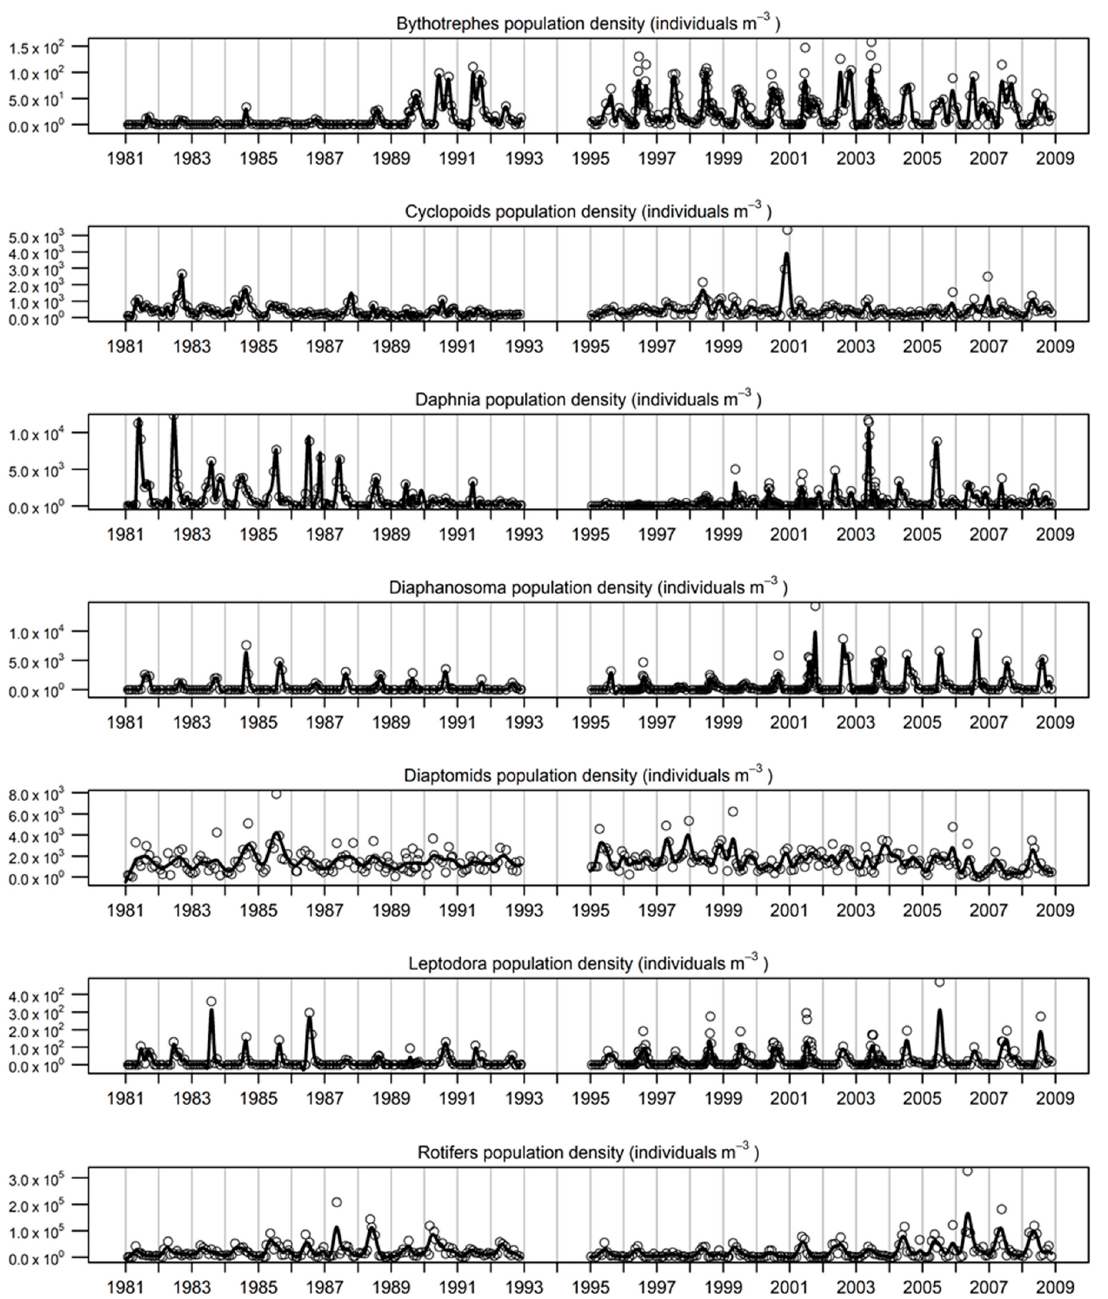
Figure 1. Observed and smoothed time series for all physico-chemical and biological variables. Continuous line = smoothed curve; circles = original data points. Panel ( A ): Physico-chemical variables. Panel ( B ): Phytoplankton-related variables. Panel ( C ): Zooplankton-related variables. Data were not available for 1993-1995. Points are monthly means, lines are the smoothed value.